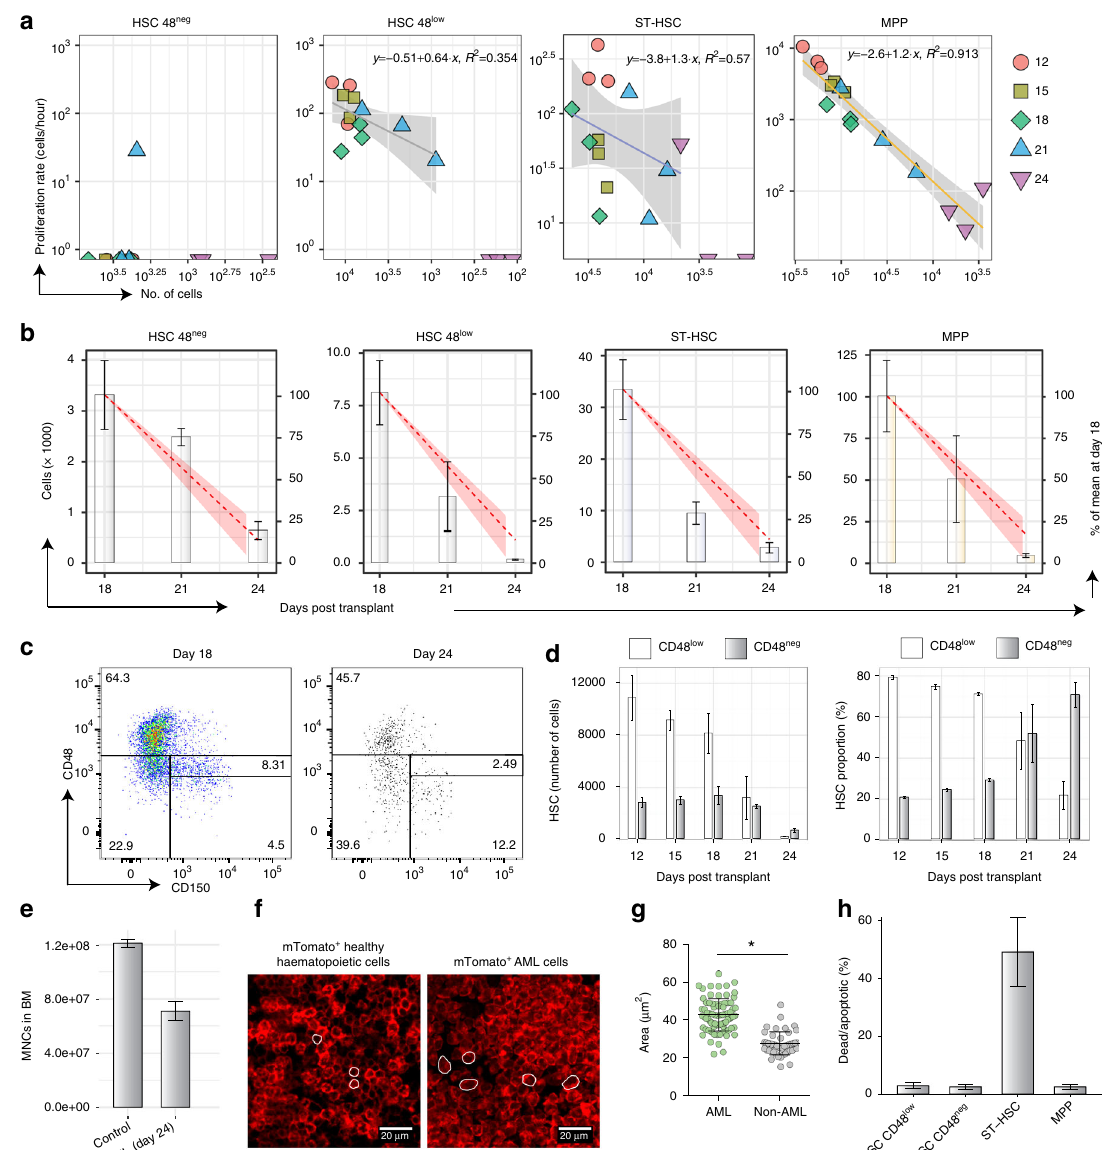
Fig. 5 Primitive haematopoietic cell populations proliferative dynamics under leukaemic stress. a Number of cells entering S phase per hour plotted against number of cells in each of the indicated cell population, colour- and shape-coded per day of analysis following AML blasts injection. Lines show linear regression with 95% con fi dence intervals shown as grey shadows. b Numbers of each analysed population per hind leg, with red dotted line and shaded area indicating the estimated cell loss based on a cell type and cell cycle independent ousting model. c Representative FACS plot of LKS cells showing CD48 neg and CD48 low gates at days 18 and 24 of disease progression, showing survival of HSCs in the CD48 neg gate. d CD48 neg and CD48 low HSC numbers (left) and relative proportions (right) as a function of time (average ± s.e.m shown). e Numbers of mononuclear cells in the hind legs BM of control and advanced leukaemic mice (average ± s.e.m; p = 0.012, Welch ’ s two-sample t -test; n = 2 control and 3 AML mice from one representative cohort). f Histological sections of BM from mice reconstituted with healthy mTmG BM MNC (left) and day 24 mTmG MLL-AF9 blasts (right). Red is membrane-bound tomato signal, while white lines provide illustrative examples of measured cells. g Cell area measurements of healthy and AML cells from day 24 of disease ( p < 10 − 4 , Welch ’ s two-sample t -test; n = 48 healthy and n = 78 AML cells measured from sections from one whole BM chimera and 3 day-24 AML-burdened mice). h Proportion of dead or apoptotic (Annexin V and/or DAPI positive) primitive cell populations in mice at an advanced stage of disease, day 24 ( p = 0.68 for CD48 neg HSC, p = 0.24 for CD48 low HSC, p = 0.06 for ST-HSCs and p = 0.3 for MPPs, Welch two-sample t -test; n = 10 control mice, n = 3 leukaemic mice). Throughout the fi gure, a representative cohort of 15 mice is shown, with 3 analysed at each time